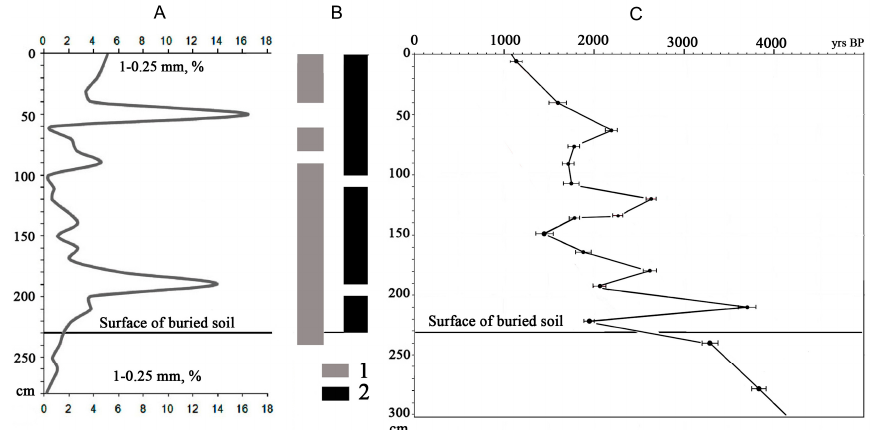
Figure 6. Distribution of sand fraction in the colluvial stratum of “Vishnyaki gully” ( A ); occurrence of pollen, spores, and phytoliths in the stratum ( B ); Radiocarbon age of soil organic matter (uncalibrated years) in different layers of the colluvial stratum and in the buried soil ( C ). 1—layers with presence of pollen and spores; 2—layers with presence of phytoliths; 3—peaks of the sand content; 4—peaks of the soil C org radiocarbon age.